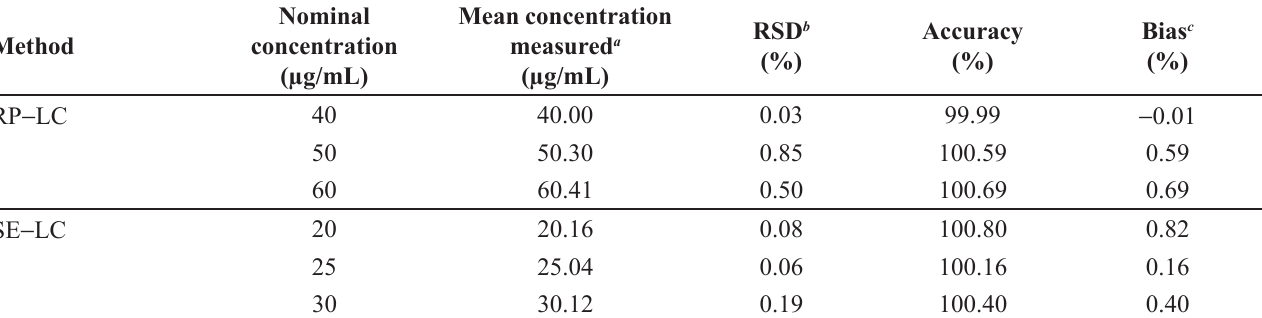
TABLE I - Accuracy of RP − LC and SE − LC for rhIFNβ − 1b in biopharmaceutical formulations